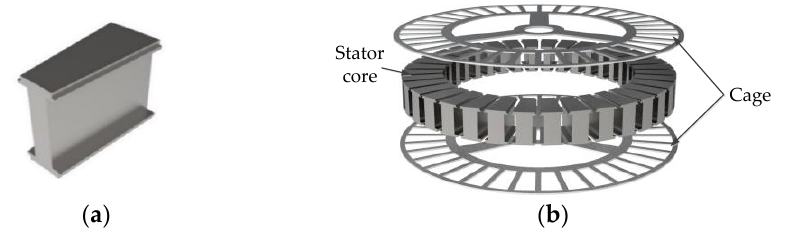
Figure 6. Simplified thermal model of the segmented stator.